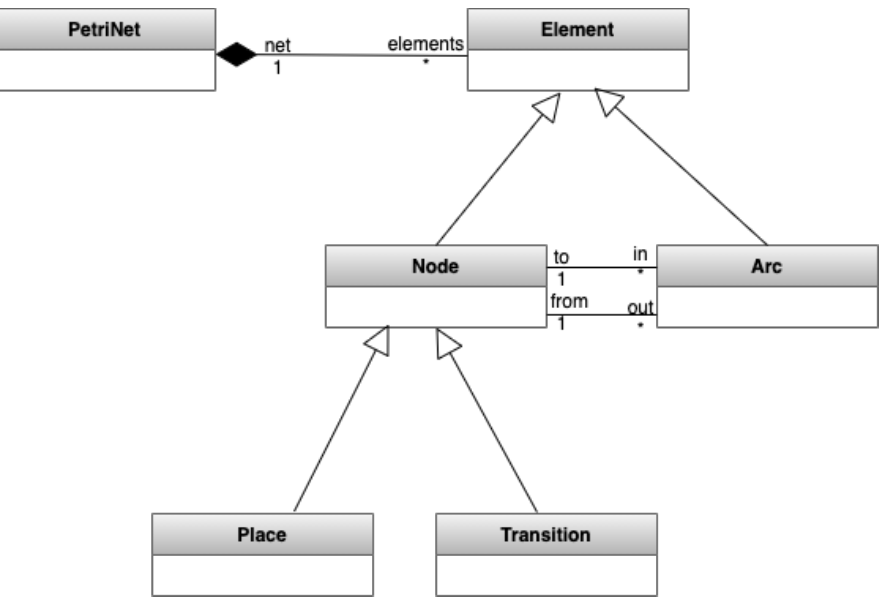
Figure 3. Petri nets meta-model. The ’*’, wildcard, means 0...n